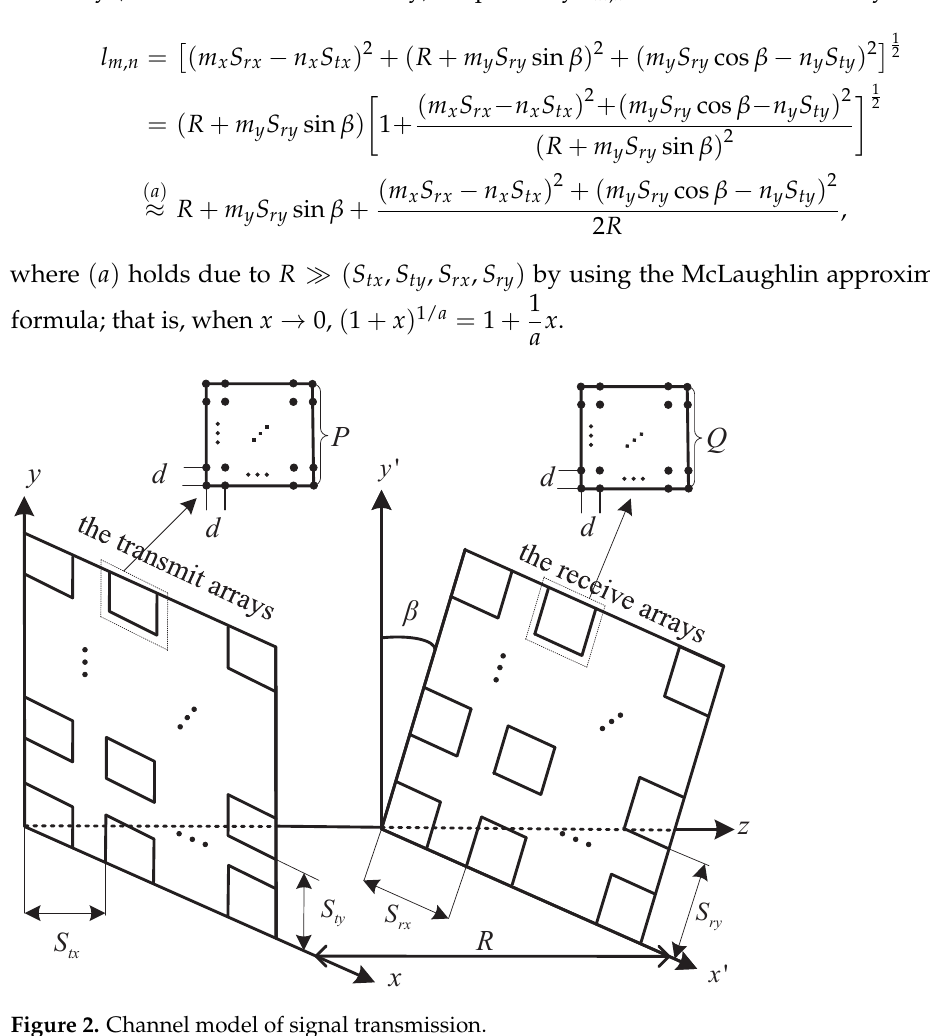
Figure 2. Channel model of signal